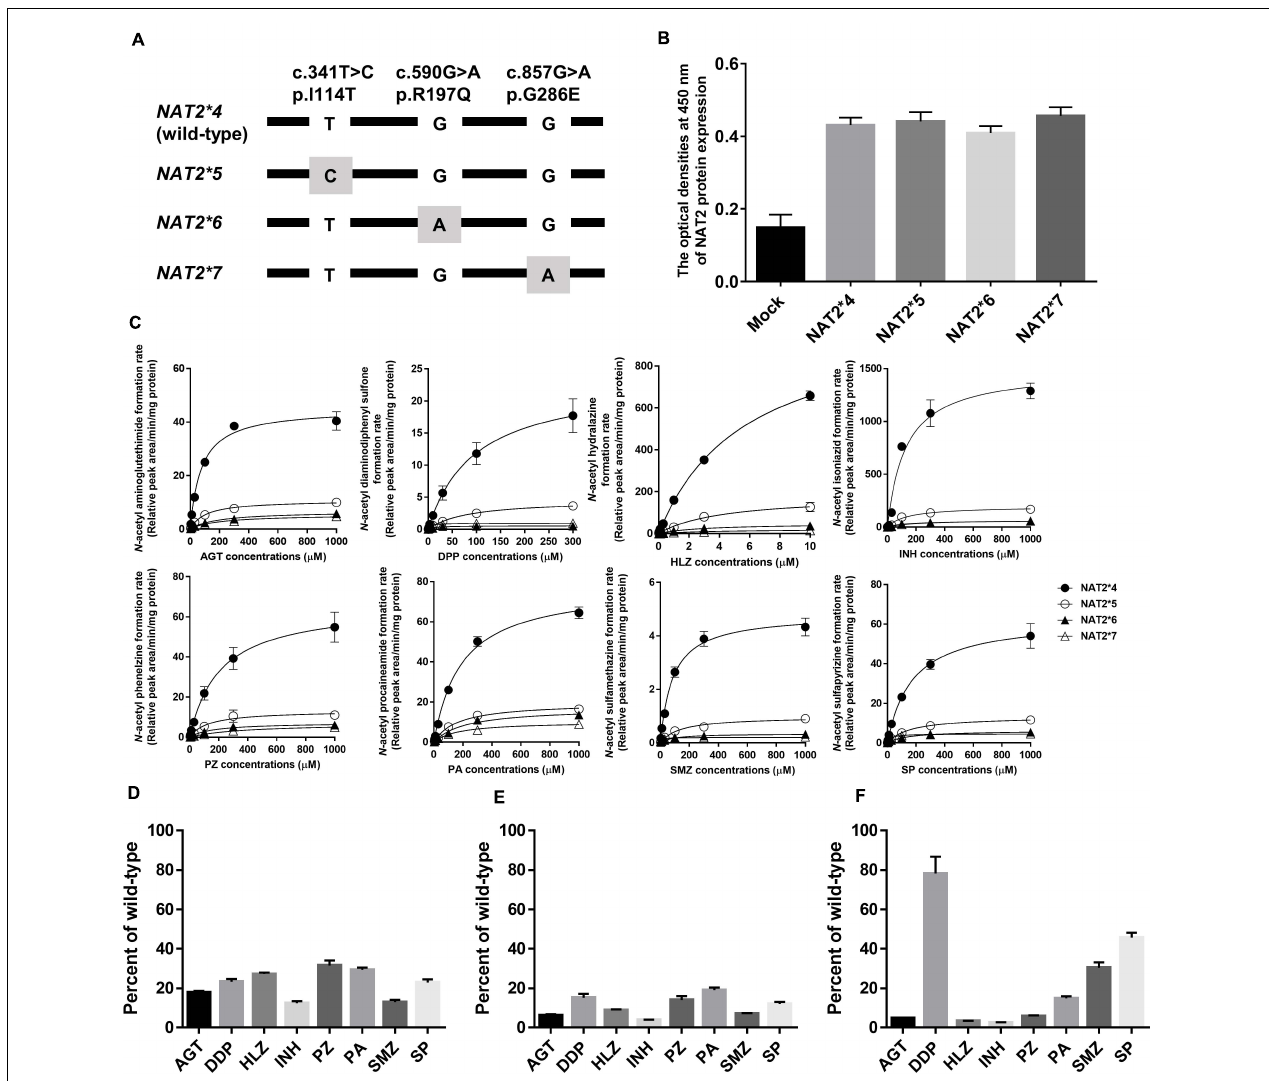
FIGURE 1 | N -Acetylation of eight drugs by NAT2 alleles. (A) Schematic of NAT2 alleles. The gray box represents signature SNVs. The nucleotide and amino acid positions are based on NM_000015.2 RefSeq. (B) NAT2 protein expression levels in lysates from HEK293 cells expressing NAT2 ∗ 4, ∗ 5, ∗ 6, and ∗ 7 alleles, as determined by ELISA. The Y axis represents the optical density at 450 nm. Each value represents the mean + SEM of four independent experiments. (C) Michaelis-Menten curves of the enzymatic activities of NAT2 proteins encoded by NAT2 ∗ 4 , ∗ 5 , ∗ 6 , and ∗ 7 alleles toward eight drugs (aminoglutethimide, AGT; diaminodiphenyl sulfone, DDP; hydralazine, HLZ; isoniazid, INH; phenelzine, PZ; procaineamide, PA; sulfamethazine, SMZ; and sulfapyrizine, SP). Each point represents the mean ± standard deviation of four determinations. Open rhombus, closed rhombus, open triangle, and closed triangle present NAT2 ∗ 4, ∗ 5, ∗ 6, and ∗ 7, respectively. (D–F) Relative CLint values of NAT2 ∗ 5 (D) , ∗ 6 (E) , and ∗ 7 (F) among eight drugs using the CLint value of NAT2 ∗ 4 as a base of 100. Each value represents the mean + SEM of four independent experiments.